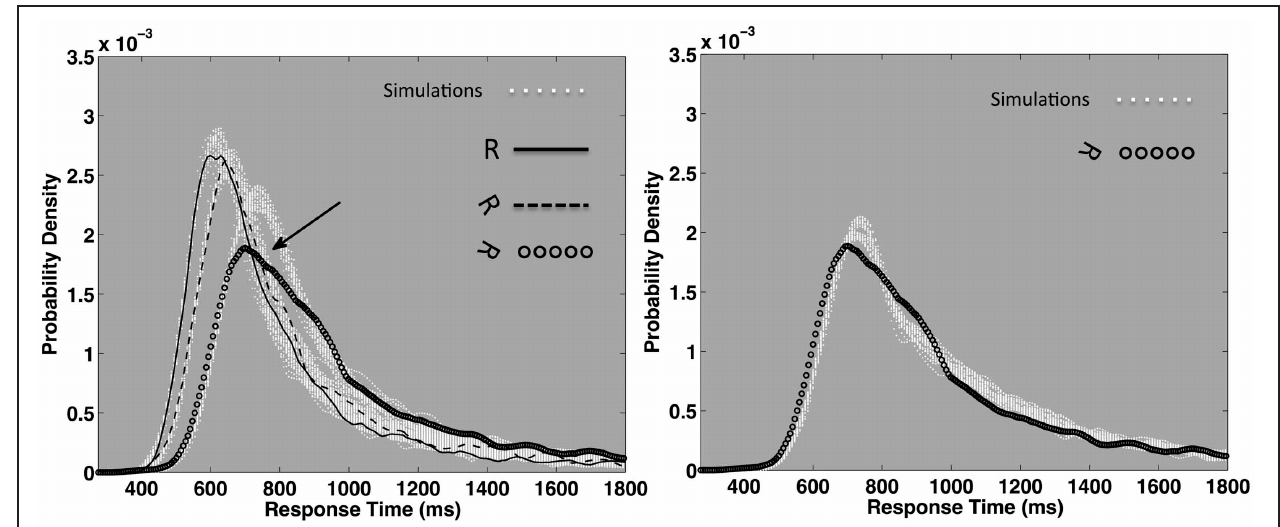
(see Table 2 ). The antilog of each synthetic distribution was then FIGURE 9 | The left-hand plot depicts the outcome of three rescaling computed, thus yielding a rescaled model for both the empirical 60 ◦ and simulations. Synthetic cocktail response times were generated based on 120 ◦ distributions. The rescaled synthetic 60 ◦ and 120 ◦ distributions are the fitted parameters for the baseline 0 ◦ condition (solid black line). Kernel smoothed densities for 22 replications of the synthetic distribution are both plotted as white points behind the empirical distributions (dashed depicted as white points, plotted behind the empirical 0 ◦ density. Rescaled line, and open circles, respectively). In this case, the pure multiplicative synthetic 60 ◦ distributions were generated by first computing the natural operation properly located the synthetic distributions, but the synthetic logarithm for each synthetic baseline 0 ◦ distribution, after which, a 120 ◦ distribution was more peaked at the mode than the empirical constant of 0.061 was added to each value. Likewise a constant of 0.173 distribution (see arrow). Additional simulations revealed that a larger (cid:2) PL and proportion of power law samples, in addition to the multiplicative was added to duplicate the baseline synthetic data and mimic the 120 ◦ distribution. These two values represent the difference between the 0 ◦ operation, were required to approximate the empirical 120 ◦ distribution, as ◦ and 120 ◦ distributions (cid:2) depicted in the right-hand plot. LN parameter and the same parameter for the 60